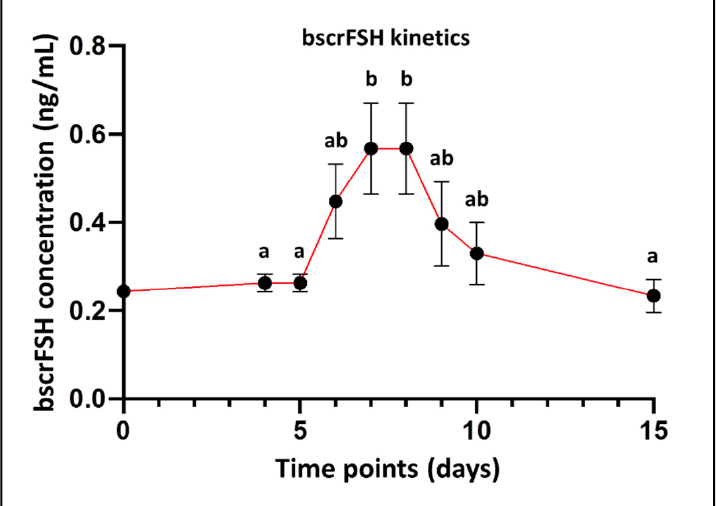
Figure 2. Bovine single-chain recombinant FSH (bscrFSH) half-life over time during the SOV protocol. Plasma bscrFSH concentrations till Day 15 after intramuscular (i.m.) administration of bscrFSH at 170 µ g total dose distributed in a single application per day, four-days schedule (55, 50, 40, and 25 µ g/day), in post-partum cows ( n = 7). Values (Mean ± S.E.M.) with different superscript letters (a,b) between time points are significantly different ( p < 0.05). Table 2. Ovarian dimensional evaluation over time: NIH-FSH-p vs. bscrFSH SOV